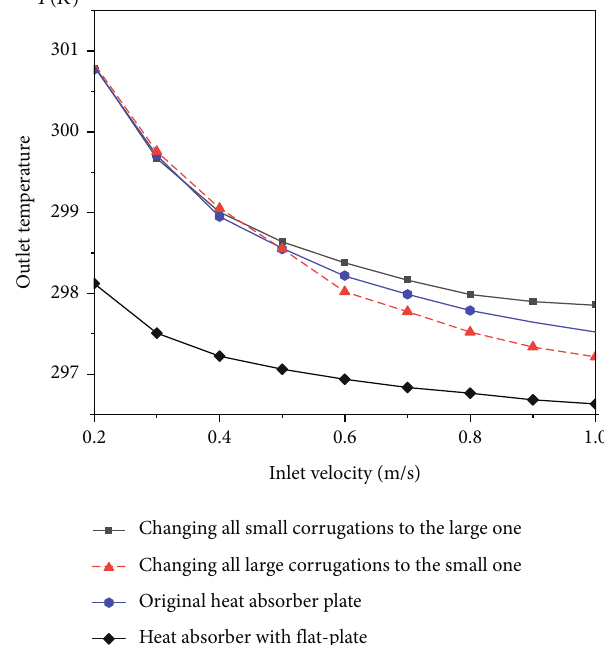
Figure 13: Outlet temperature comparison of three types of absorber plates after changing corrugation